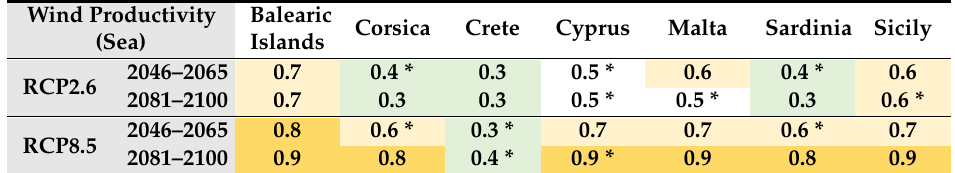
Table 4. As for Table 3, but for wind productivity over the sea. Domains considered for the calculations are shown in Table 1. The * indicates the cases in which Nu > 0.5.